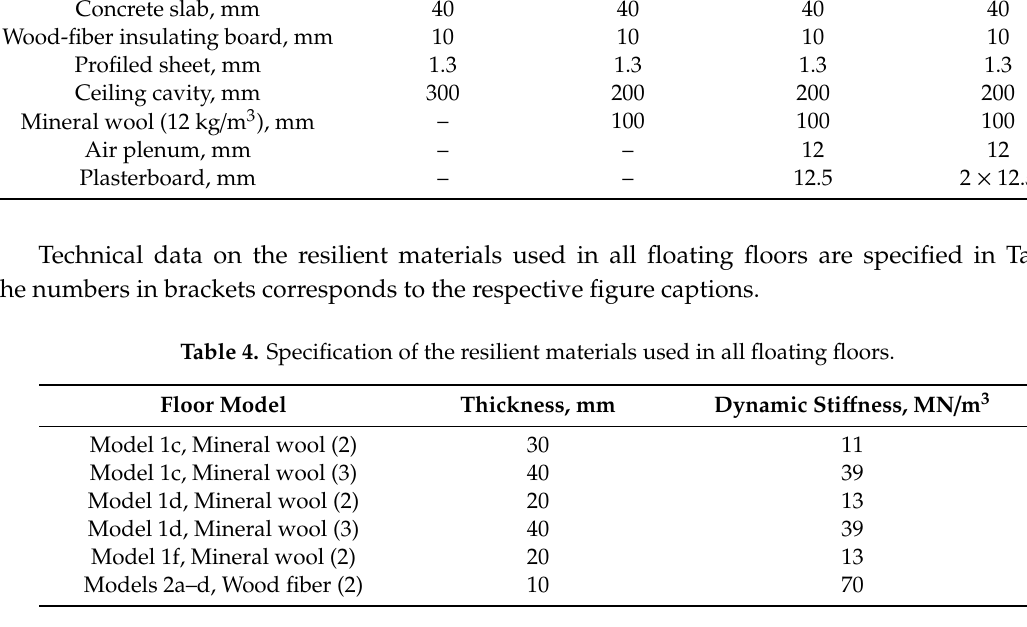
Figure 5. Cross-sections of a metal frame floor: ( a ) Basic construction (model 2a); ( b ) Construction filled with a glass wool (model 2b); ( c ) Construction with a single plasterboard (model 2c); ( d ) Construction with a double plasterboard. 1 – concrete slab, 2 – wood-fiber insulating board, 3 – profiled sheet, 4 – steel trusses, 5 – air gap, 6 – glass wool ρ = 12 kg/m 3 , 7 – plasterboard. Table 3. Specification of the metal frame floors (models 2a–d). Layers (from Top to Bottom)